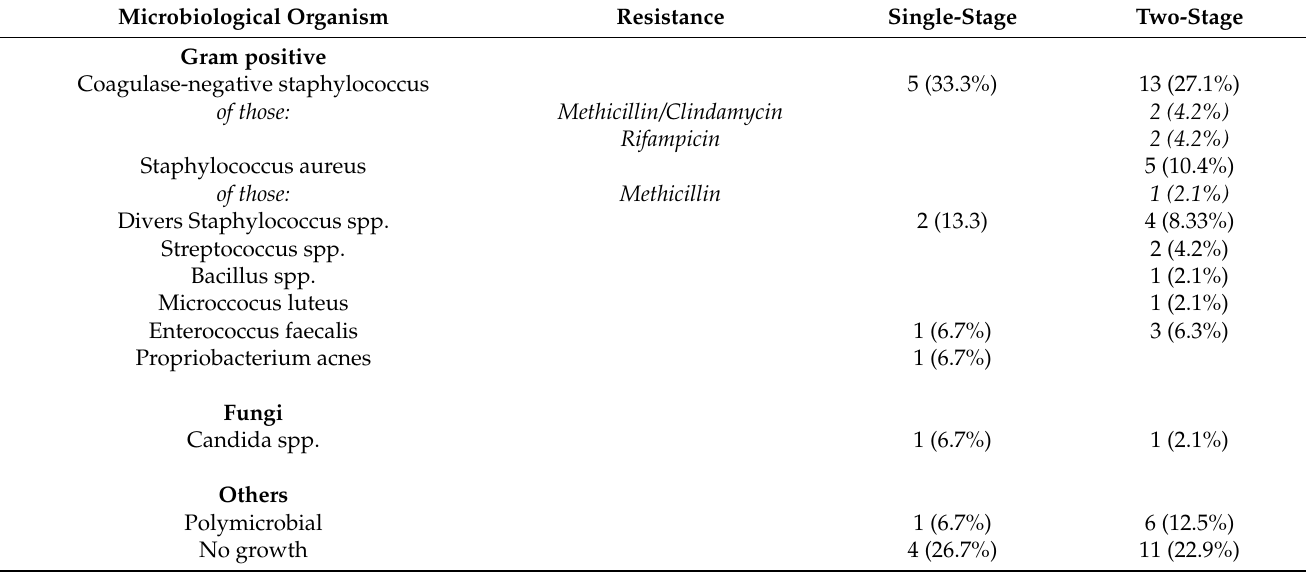
Table 2. Distribution of microbiological